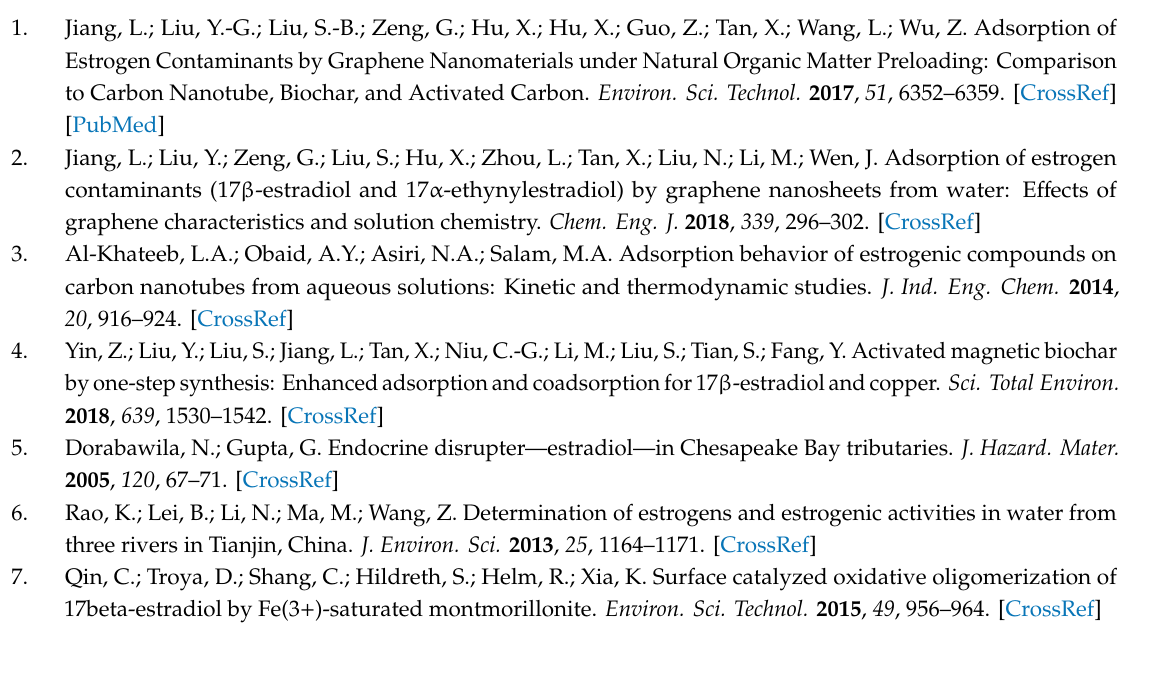
Figure S1: N 2 adsorption-desorption isotherms of samples (a) BC; (b) 1:1 / 900 ◦ C; (c) 1:1 / 800 ◦ C; (d) 1:1 / 1000 ◦